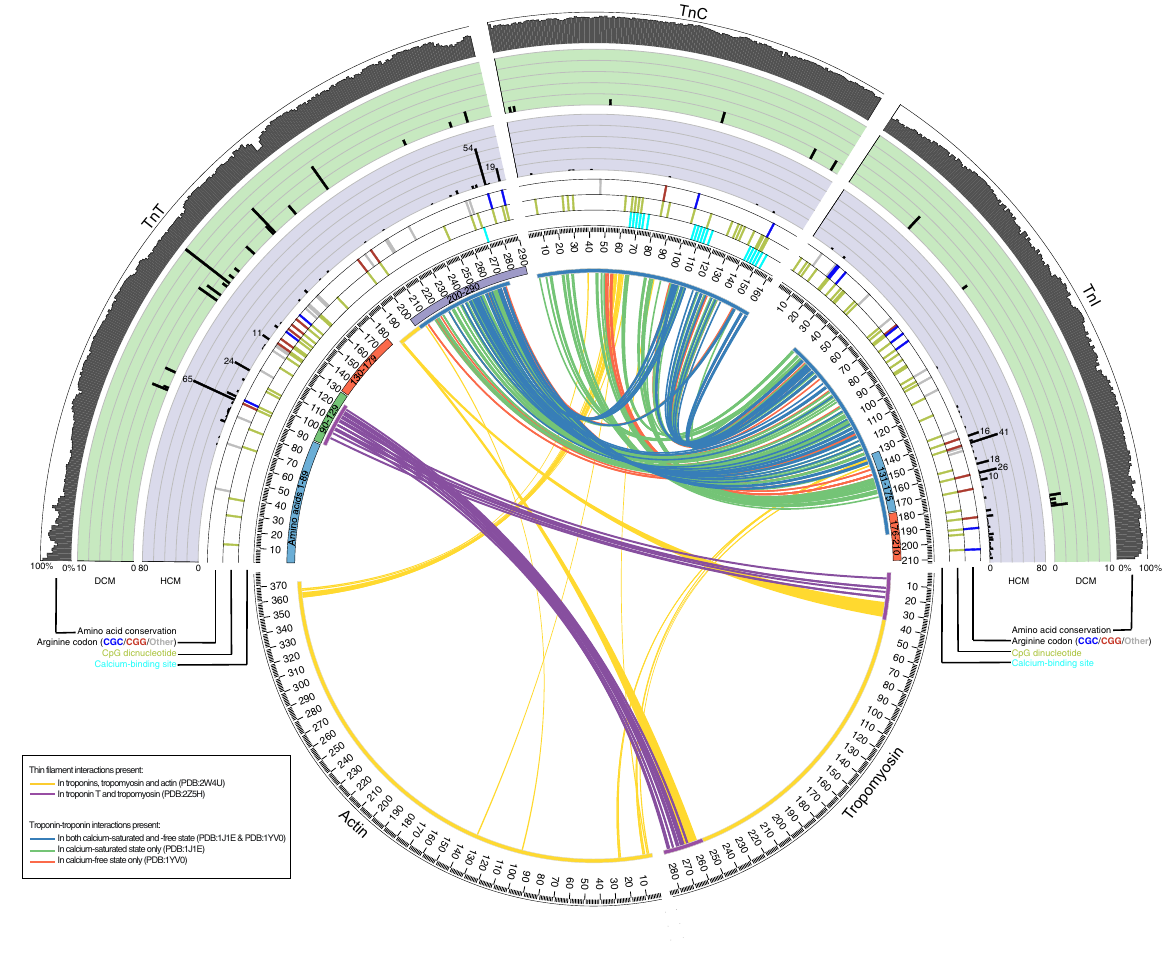
Fig. 1 Human cardiac thin fi lament genetic variants and structural changes during calcium binding. The centre depicts interactions closer than 4 Å between pairs of residues in human cardiac thin fi lament are depicted as coloured arcs: interactions unique to calcium-saturated state (PDB:1J1E) (green); interactions unique to calcium-free state (PDB:1YV0) (red); interactions common to both calcium-saturated and calcium-free state (blue); interactions between troponins, tropomyosin and actin (PDB:2W4U) (yellow); and interactions between TnT and tropomyosin (PDB:2Z5H) (purple). Radiating out from the centre, rings show: extent of protein sequence resolved by crystallography; protein domains; amino acid residue numbers; location of calcium-binding residues (cyan); location and frequency of variants reported causative of hypertrophic cardiomyopathy (HCM) (purple background); location and frequency of variants reported causative of dilated cardiomyopathy (DCM) (green background); and conservation of each amino acid across ten species (grey histogram). Figure was generated by using Circos 11